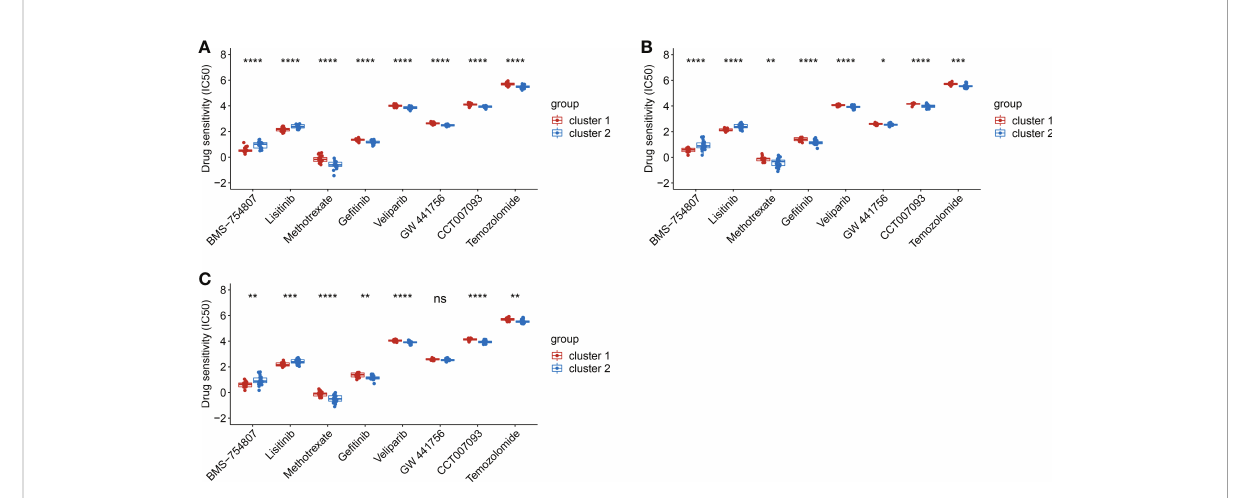
FIGURE 7 The comparison of drug sensitivity between cluster 1 and cluster 2. (A) . The comparison of drug sensitivity in training dataset. (B) . The comparison of drug sensitivity in test dataset. (C) . The comparison of drug sensitivity in the predicted cluster 1 and cluster 2 in test dataset. (*p< 0.05; **p< 0.01; ***p< 0.001; ****p<